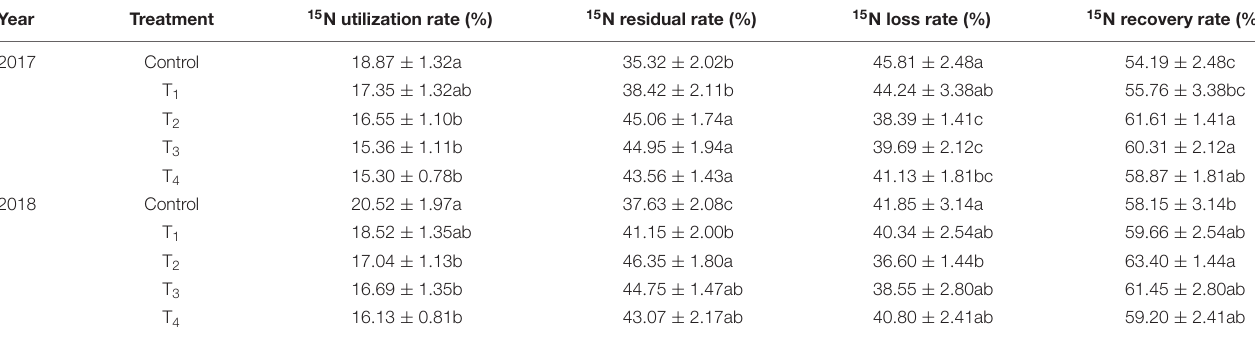
TABLE 2 | Effects of DMPP on the utilization, residue and loss of 15 N.